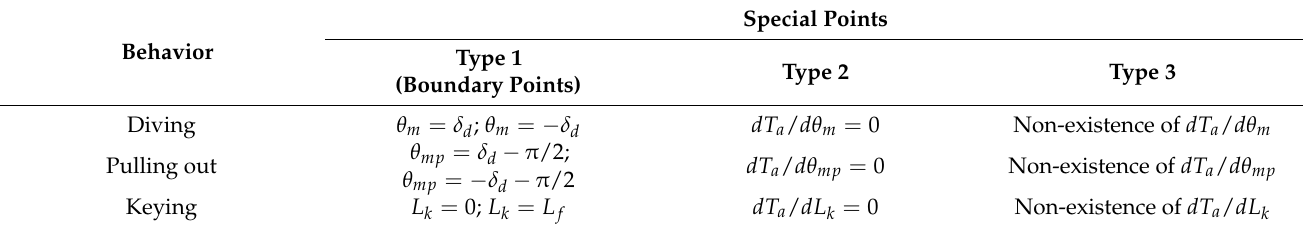
Table 1. Special points to acquire T a , min corresponding to various types of